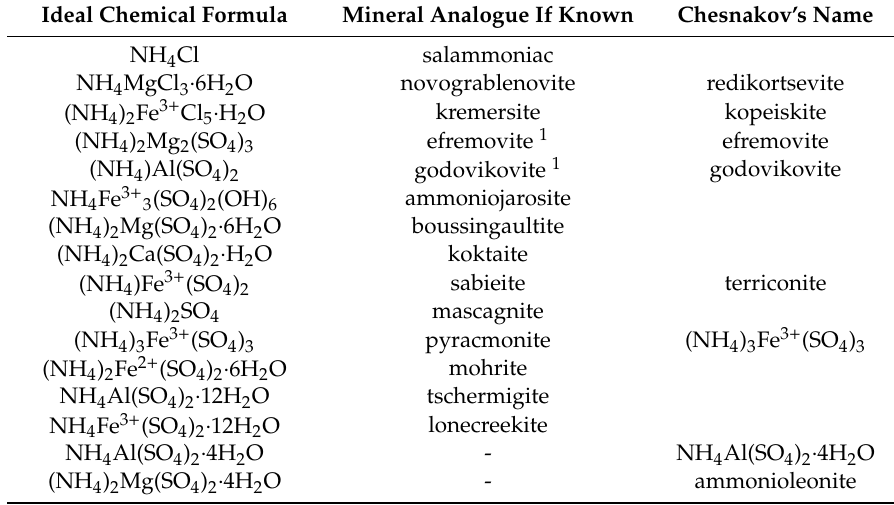
Table 2. Ammonium phases described in the burned dumps of the Chelyabinsk coal basin by Chesnokov et al.